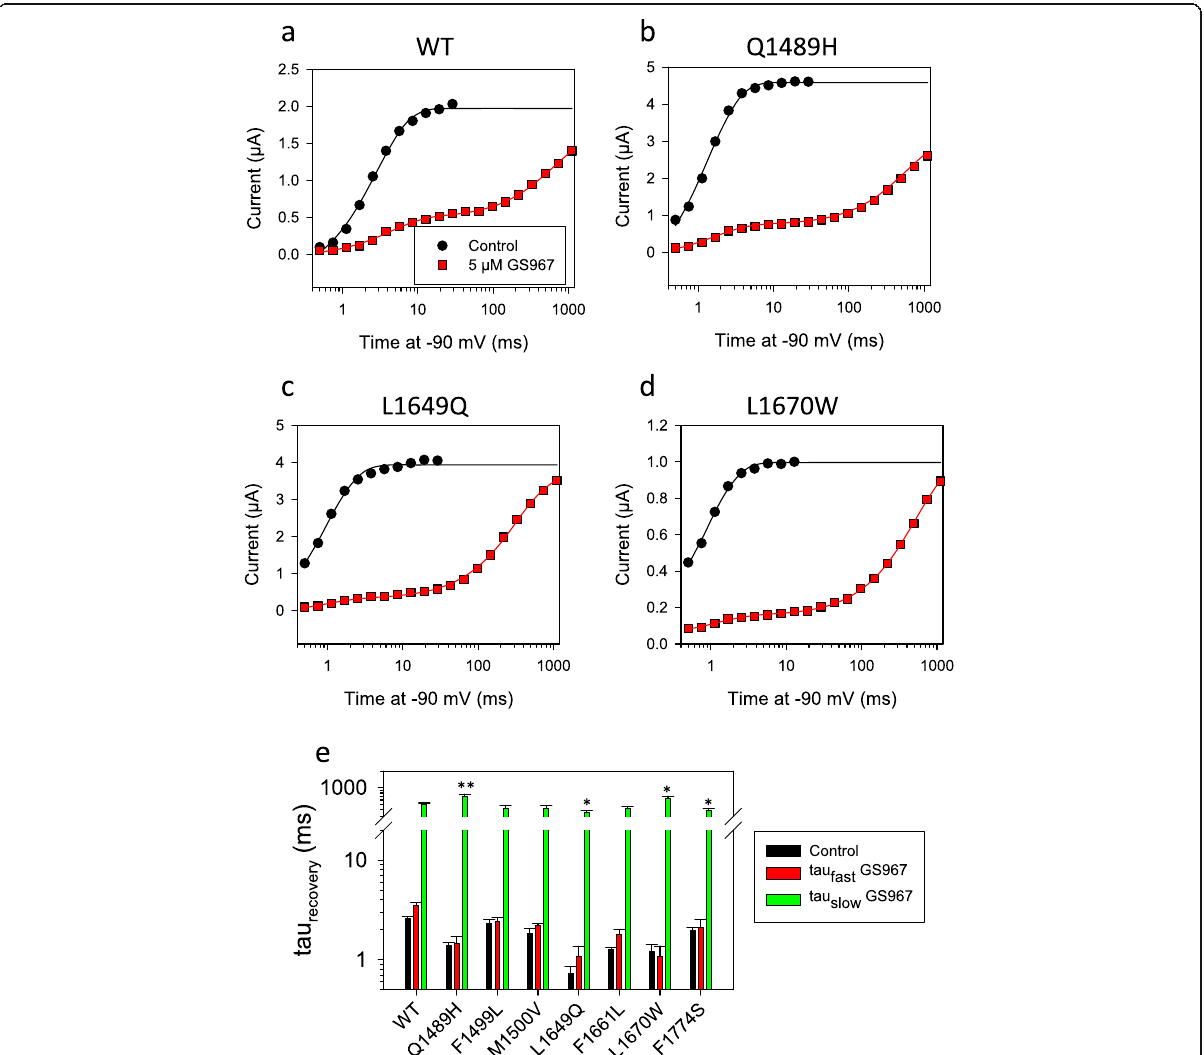
Fig. 4 GS967 prolongs recovery from inactivation for WT and all mutants. a - d show typical results for the indicated constructs for measurements of the recovery from inactivation at − 90 mV before (black symbols) and after (red symbols) application of 5 μ M GS967. Black lines are single exponential fits, red lines are fits of a double exponential function. e shows the average rime constants of recovery before and after application of